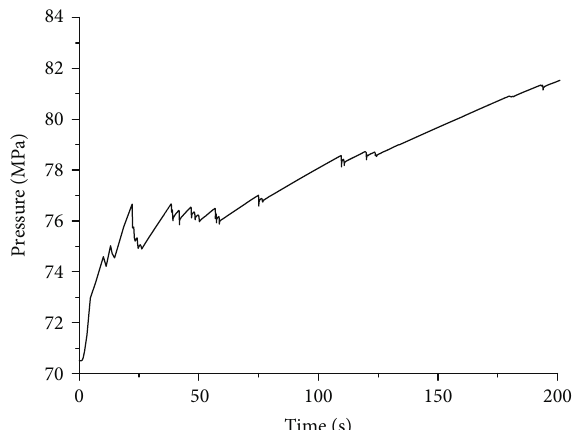
Figure 34: Pressure curve at the NF approaching angle of 60 ° and under stress anisotropy coe ffi cient of